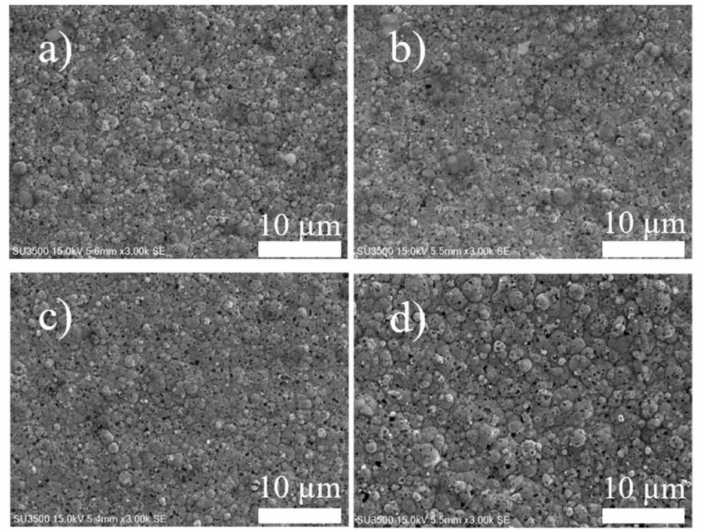
Figure 3. SEM images of Ni–W/B coatings electrodeposited at a boron concentration of 10 g/L, peak current density of 0.20 A/cm 2 , 50% duty cycle and different frequencies: ( a ) 40 Hz, ( b ) 60 Hz, ( c ) 80 Hz, and ( d ) 100